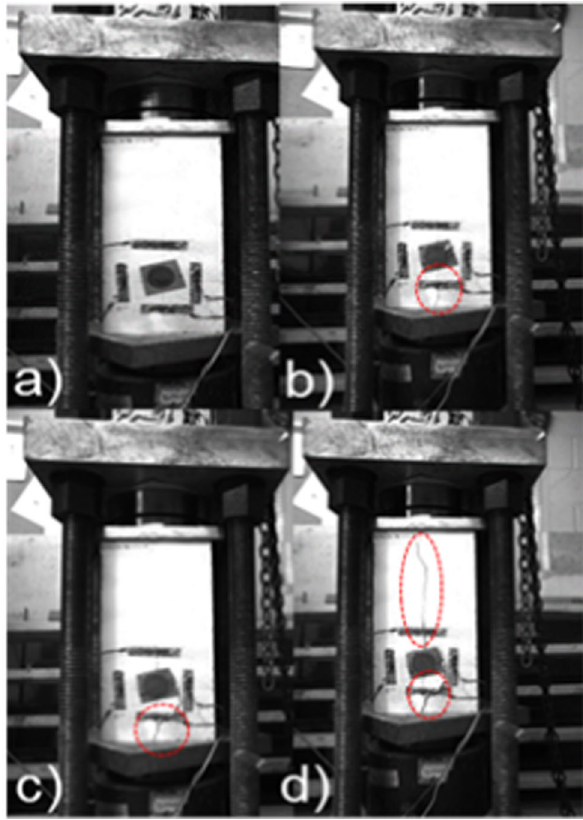
Fig. 21 G-SL2-175-700-LT-L a At time t age at t 7 d Complete breakage at t